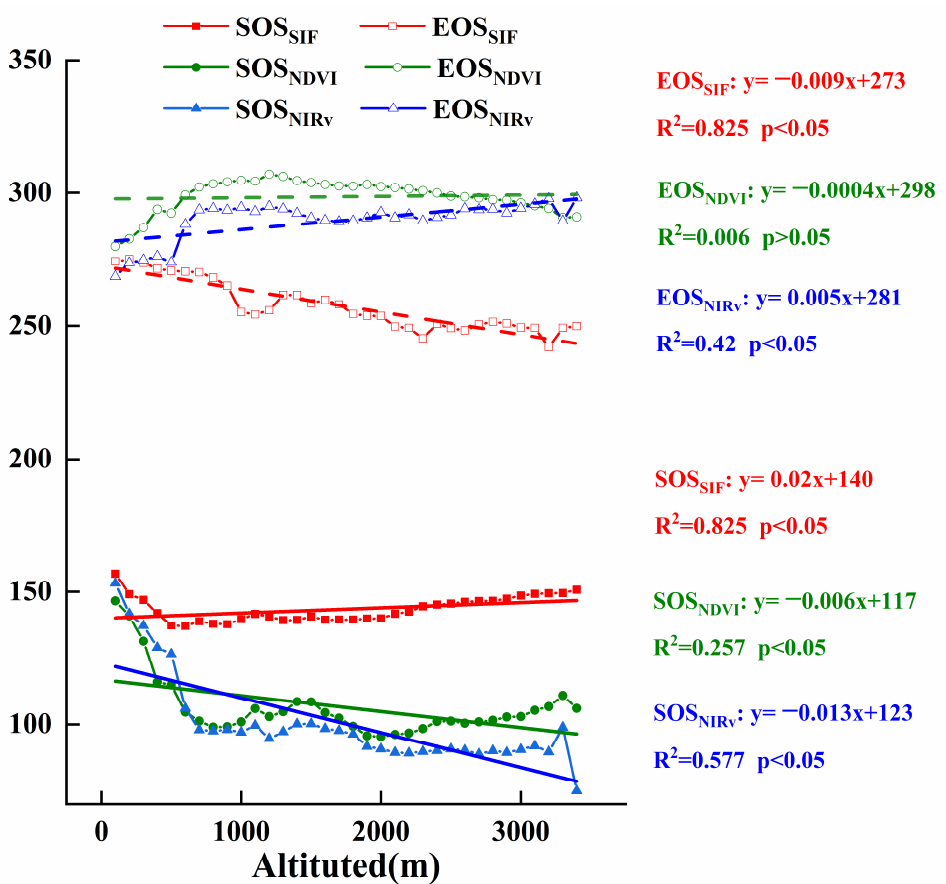
Figure 5. Characteristics of vegetation phenology changes with altitude.